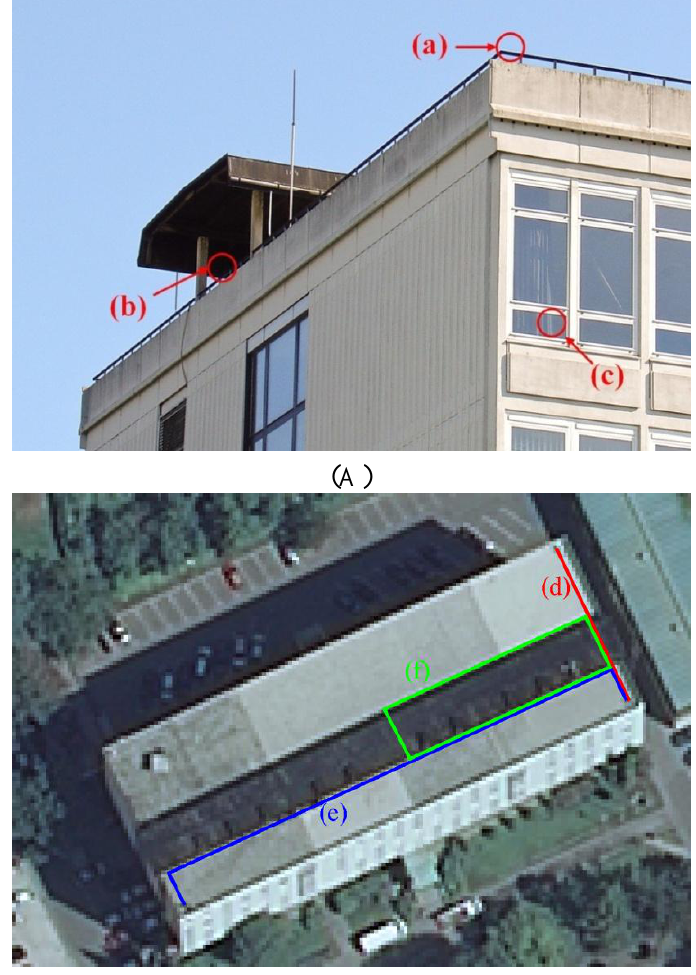
Figure 2. (A) Reference points: (a) normal conditions; (b) adverse conditions; (c) indoors. (B) Kinematic survey outlines on an orthophoto image: (d) mixed conditions; (e) mixed conditions; (f) adverse